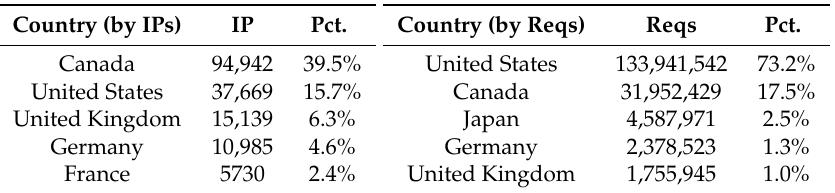
Table 3. IP geolocation distribution, top five countries.